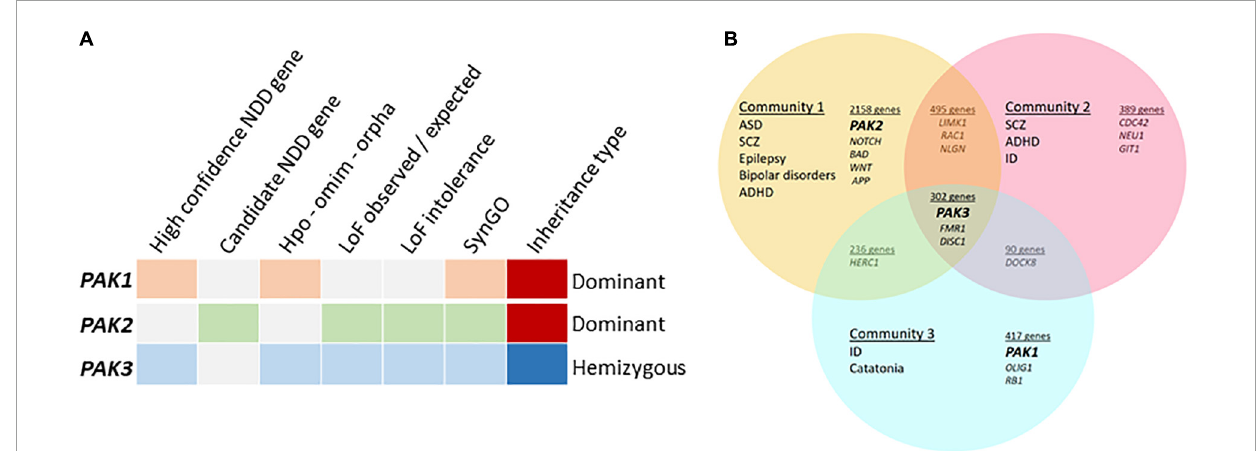
FIGURE2 Meta-analyses of group I PAK-associated NDDs (A) PAKs in different databases, categories highlighted when PAK1 (orange), PAK2 (green) or PAK3 (blue) are detected. The high confidence NDD gene category was created by GeneTrek (Leblond et al., 2021) using data-mining from SFARI, SPARK, SyslD, DDG2P, and DBD databases. The candidate NDD gene category includes candidate risk genes from the same databases (except SPARK). HPO-OMIM-Orpha: other databases. Loss of function (LOF) observed or expected: LOF can be expected from genes in this category. LOF intolerance corresponds to genes for which LOF leads to pathogenic effects. Genes from SYNGO database encode synaptic proteins. (B) PAK genes are associated with different community of diseases identified by Vilela et al. (2022).